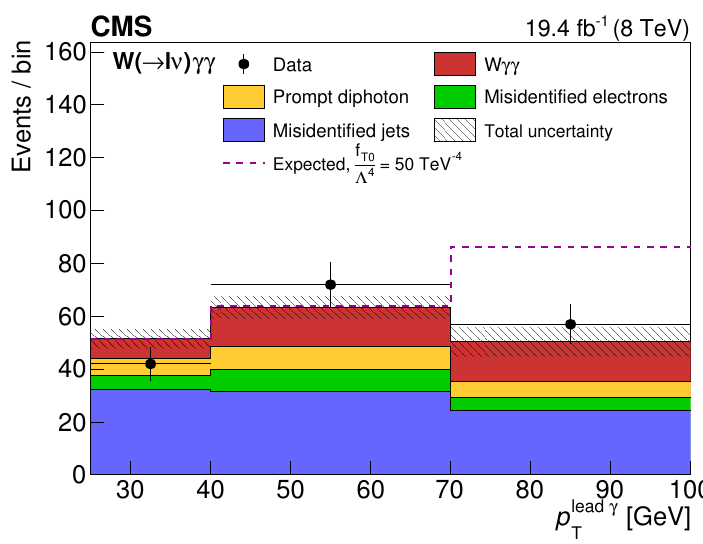
Figure 3 . Distributions of the leading photon p T for the W (cid:13)(cid:13) analysis with the electron and muon channels summed. The points display the observed data and the histograms give the predictions for the background and signal. The indicated uncertainties in the data points are calculated using Poisson statistics. The hatched area displays the total uncertainty in the sum of these predictions. The expected distribution with the inclusion of an aQGC with f T ; 0 = (cid:3) 4 = 50 TeV (cid:0) 4 is shown as the dashed line. The last bin includes all events in which the leading photon p T exceeds 70 GeV.